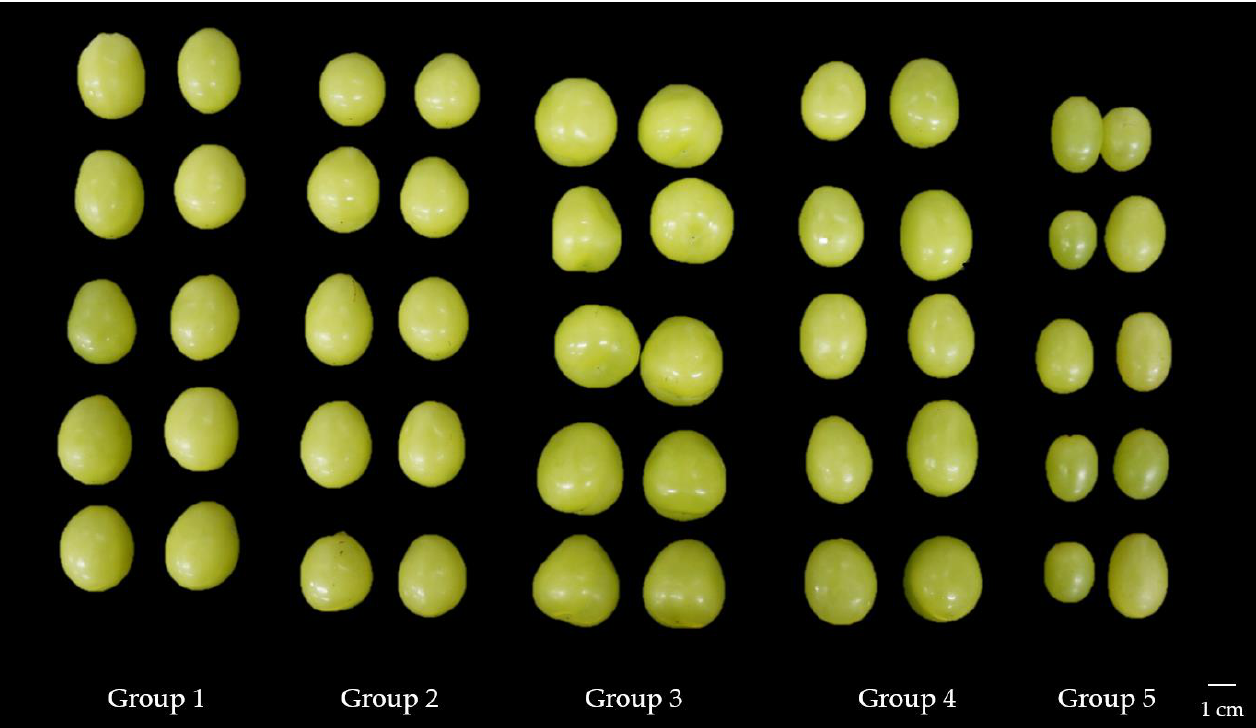
Table 3. Effects of gibberellic acid 3 (GA 3 ), thidiazuron (TDZ), and forchlorfenuron (CPPU) appli-